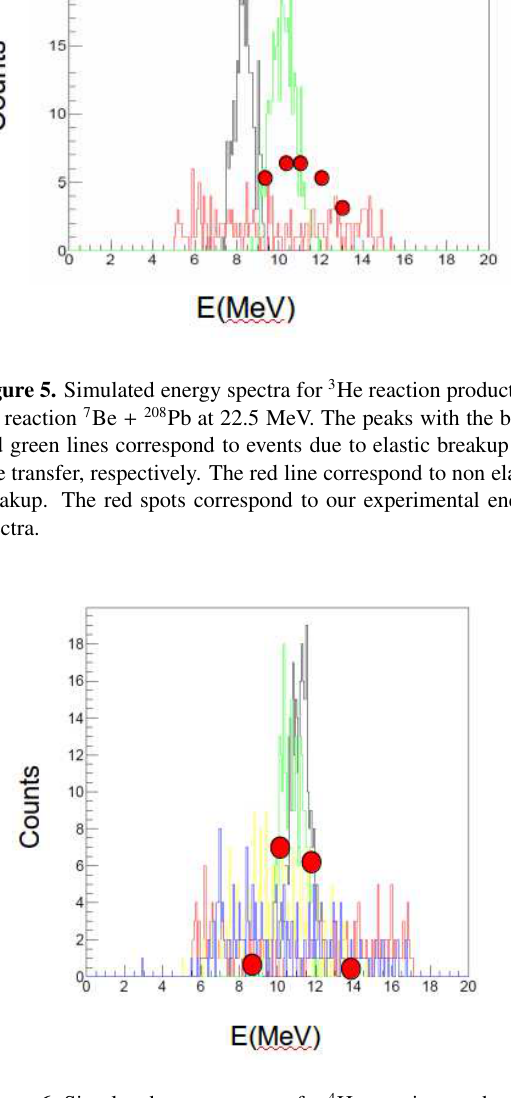
Figure 6. Simulated energy spectra for 4 He reaction products of the reaction 7 Be + 208 Pb at 22.5 MeV. The peaks with the black and green lines correspond to events due to elastic breakup and 3 He transfer, respectively. Other lines correspond to all other processes underlined in the text. The red spots correspond to our experimental energy